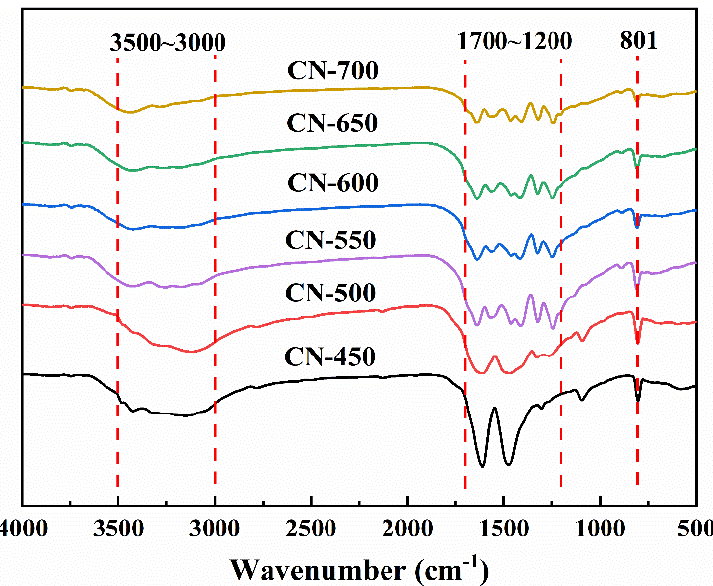
Figure 4. FT-IR spectra of CN-450, CN-500, CN-550, CN-600, CN-650, and CN-700. The EA of different samples is shown in Table 2. As the calcination temperature increased, the N, H contents of CN-X gradually decreased, while the C content showed an opposite tendency. This was attributed to the escape of H atoms and part of the N atoms in the form of NH 3 during the heating process, leaving C atoms and part of the N